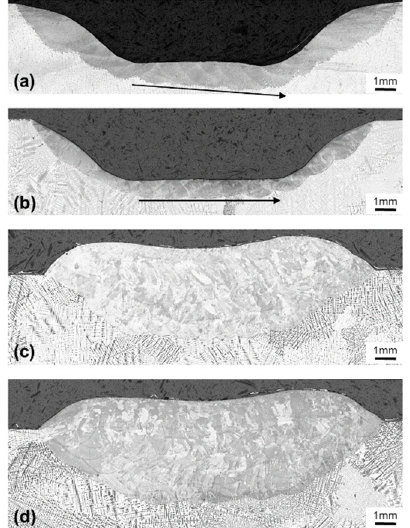
Figure 16. Groove cross sections after ( a ) laser remelting with constant scanning speed ( v = 300 mm/min), ( b ) laser remelting with variable scanning speed ( v = 250–400 mm/min), ( c ) DMD groove filling only without prior remelting, and ( d ) laser remelting with variable scanning speed and DMD groove filling.